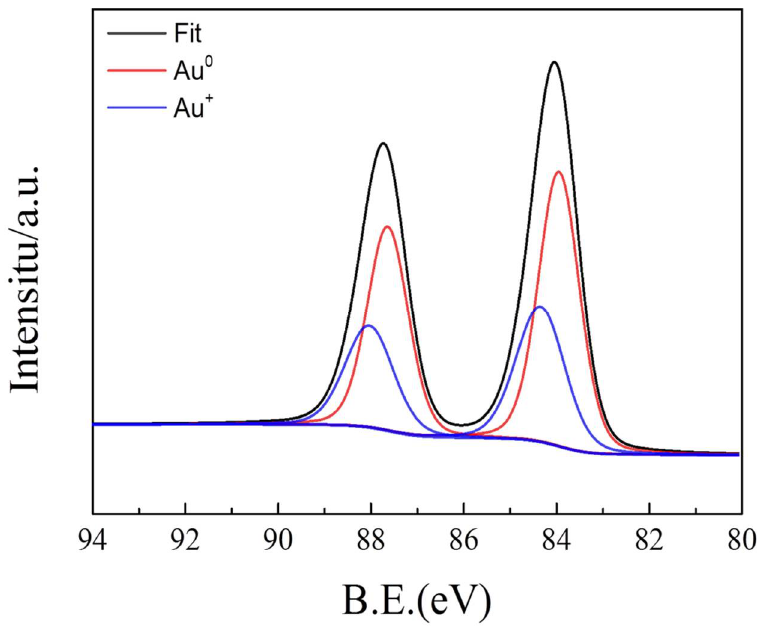
Figure 8. The fitting curves of deconvoluted XPS spectra for Au 4f on AuNPs/PEDOT:BSA/Pt electrode.